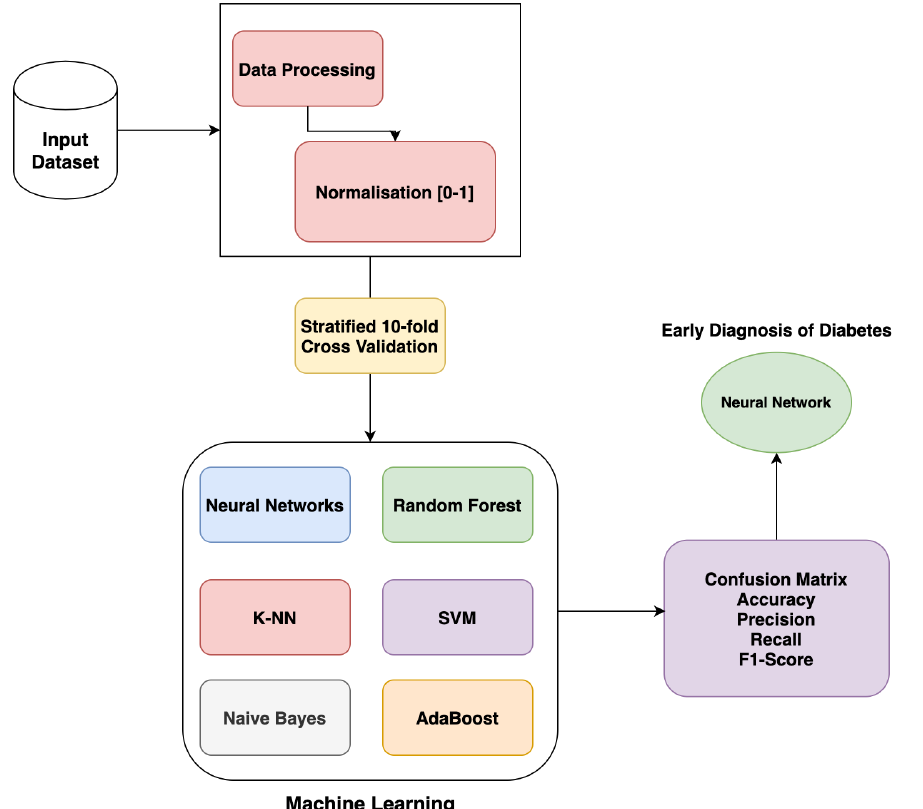
Figure 1. Experimental